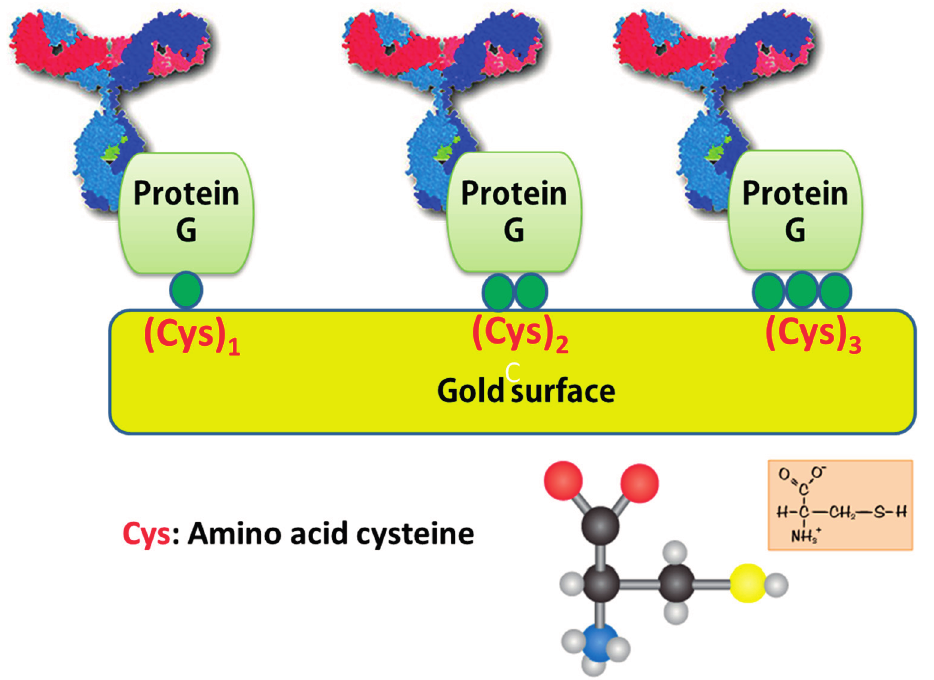
Figure 6. Schematic representation of direct immobilization of antibodies genetically modified with cysteines on a gold surface. A series of protein Gs containing two repeated IgG binding domains (B1 and B2) and a various numbers of cysteine amino acids, (Cys) 1 , (Cys) 2 , and (Cys) 3 , were genetically constructed, expressed/purified from E. coli , and subsequently analyzed using SPR biosensor. Adapted from